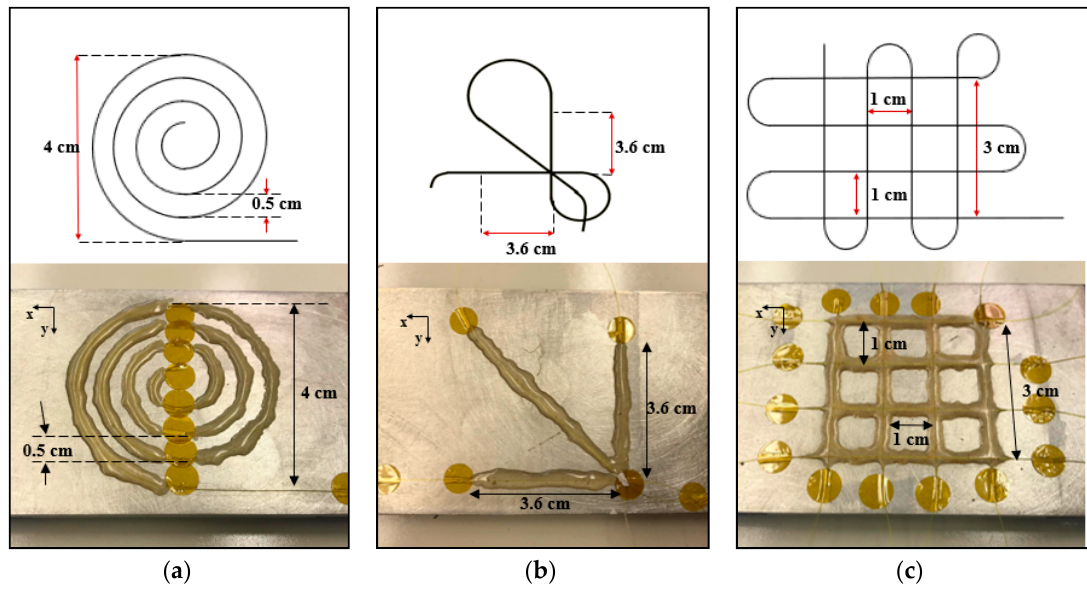
Figure 3. Optical fiber sensors in ( a ) spiral, ( b ) rosette, and ( c ) grid configurations. Table 1. Mechanical Properties of Aluminum, Adhesive and Optical Fiber.